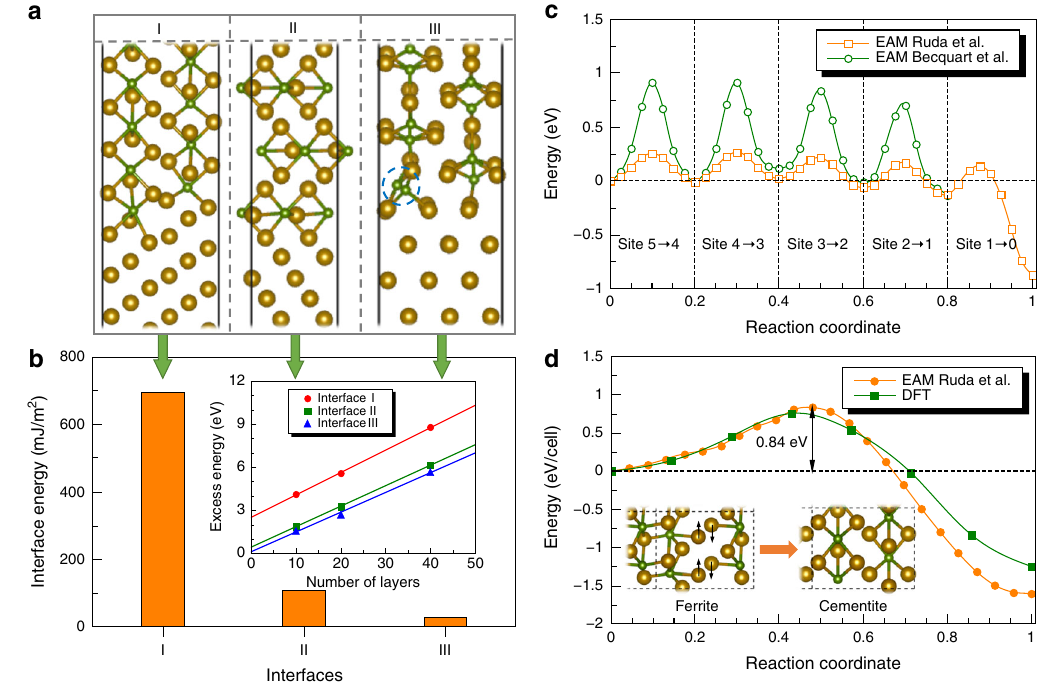
Fig. 4 Ferrite/cementite interface structures and C segregation. a Atomic structures of three binary interfaces formed between cementite and ferrite during precipitating. Gold spheres represent Fe atoms and green spheres refer to C atoms. The blue dashed circle highlights the special C sites at interface III. b The corresponding interface energy of the three binary interfaces. The inset shows the excess energy as a function of the number of layers used for constructing the binary interfaces. c The energy pro fi le of a C atom during its segregation to the interstitial site at the interface, which effectively goes through interstitial site 5 to 0 as shown in Fig. 1. d The minimum energy path of the bcc ferrite (with C atoms) → cementite transition computed using both EAM potential and DFT. The inset shows the structural change from ferrite to cementite, which is realized by collective displacements of Fe (shuf fl ing as indicated by the black arrows) and C